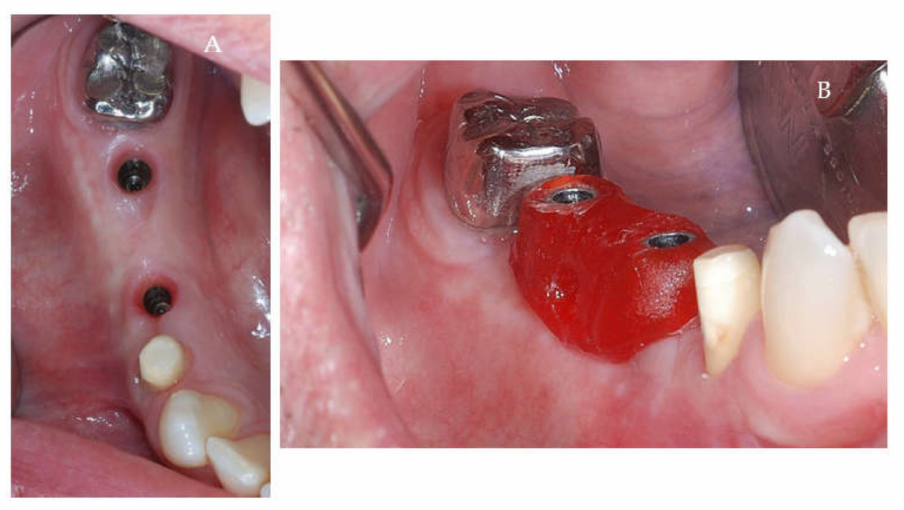
Figure 9. ( A , B ) Post-operative clinical aspects 3 weeks after second stage surgery. ( A ) Healthy peri-implant soft tissues ( B ) The repositioning key of abutments.